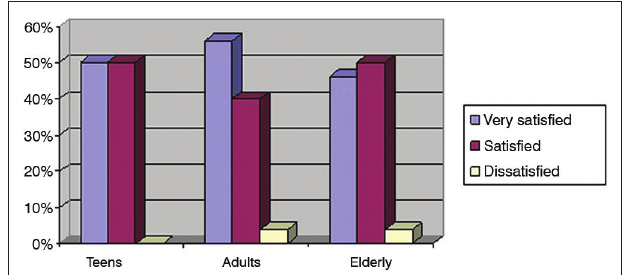
Figure 2. Percent distribution of patient ages per level of global satisfaction.